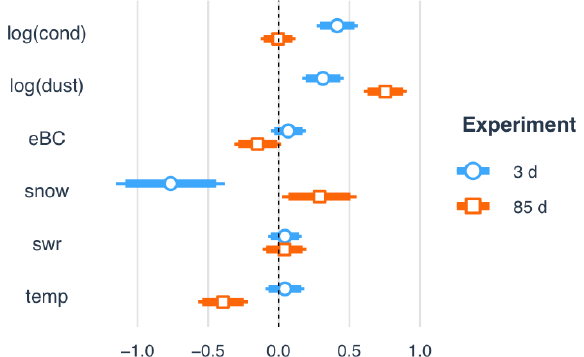
Figure 4. Estimated coefficients of the standardized covariates of the multiple linear regression models fitted to the 3 and 85d experi- ments. The segments correspond to 95% confidence intervals about the corresponding estimated coefficients. The internal thicker seg- ments correspond to 90% confidence intervals. Intervals that do not include zero correspond to statistically significant covariates. If a confidence interval consists of positive values, then there is a sig- nificant positive association between the corresponding covariate and the logarithm of the snow rBC mass concentration condition- ally to the remaining covariates and vice versa; if the confidence interval consists of negative values, then the association is negative. The abbreviations used in the plot are as follows: log(cond) – log- arithm of the water conductivity time series; log(dust) – logarithm of the coarse-mode particles number concentration time series; eBC – equivalent black carbon atmospheric concentration; snow – pres- ence of snow precipitation episodes; swr – short-wave radiation; temp – the snow temperature. The plot is produced with the R pack- age (R Core Team, 2020) jtools (Long,